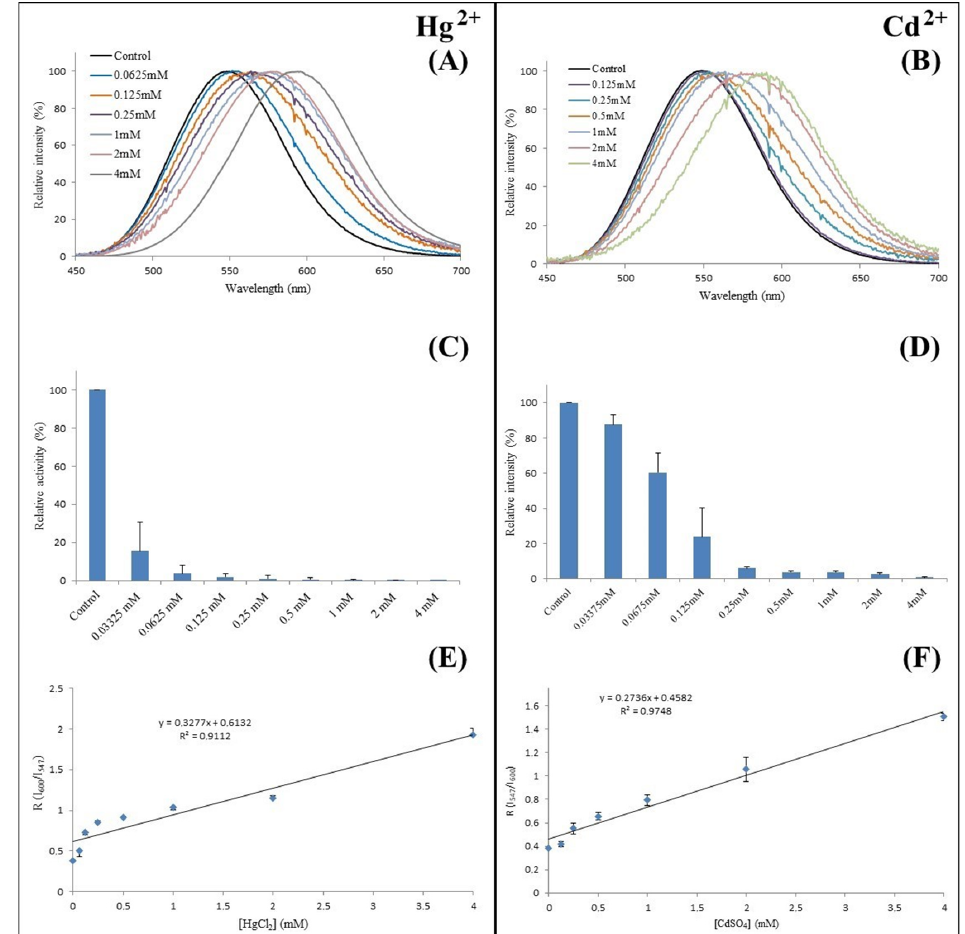
Figure 11. Use of Amydetes viviani firefly luciferase as cadmium- and mercury-selective luciferase: ( A , B ) bioluminescence spectra in presence of mercury and cadmium; ( C , D ) bioluminescence activity in presence of mercury and cadmium; ( E , F ) ratio of luminescence intensities in green and red regions in presence of mercury and cadmium. Reprinted with permission from ref. [84]. Copyright 2019 National Library of Medicine.